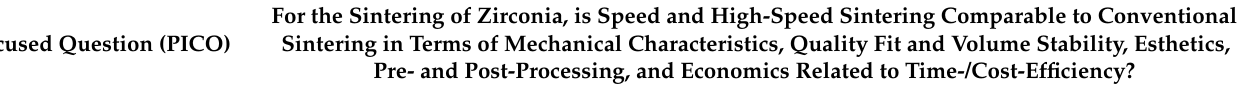
Table 1. PICO search